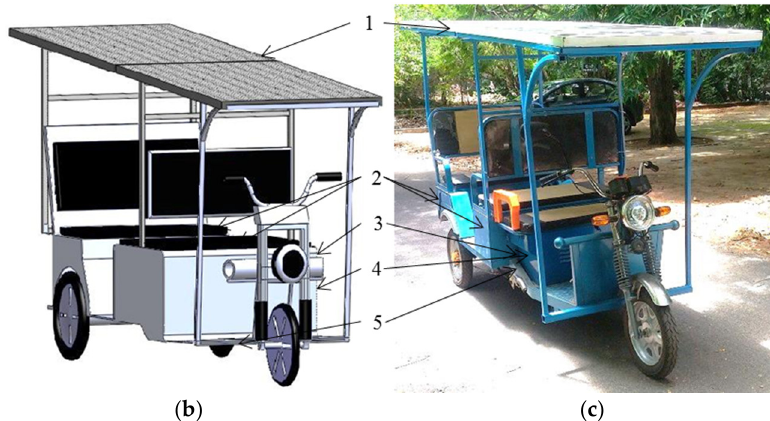
Figure 2. ( a ) Line diagram of solar powered electric auto-rickshaw (SPEA) operation; ( b ) SPEA model developed in Solid Works; and ( c ) Fabricated SPEA at IIT Madras.